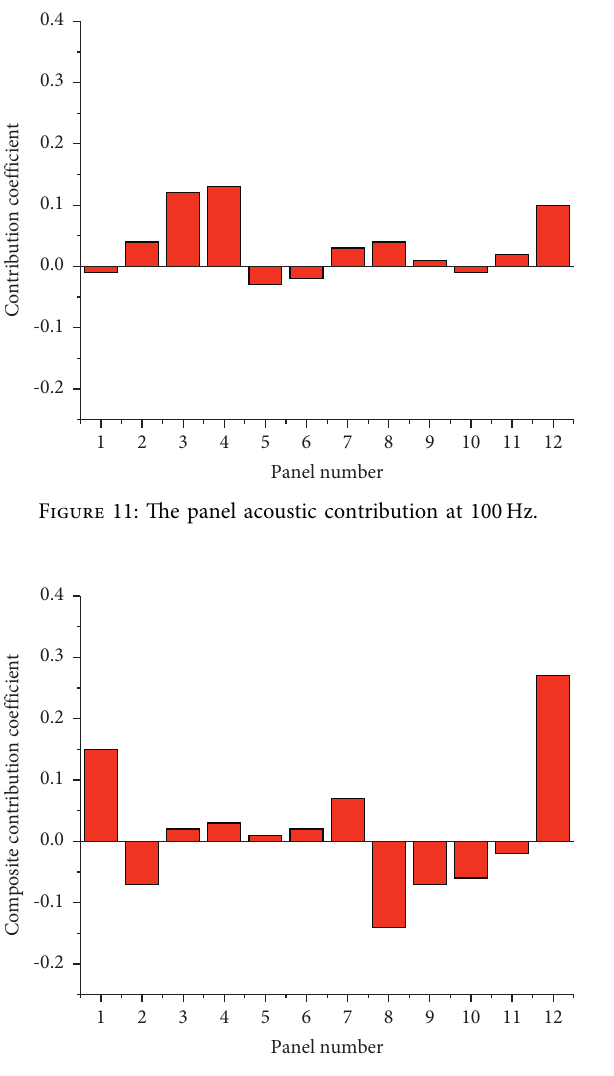
Figure 12: The composite panel acoustic contribution.